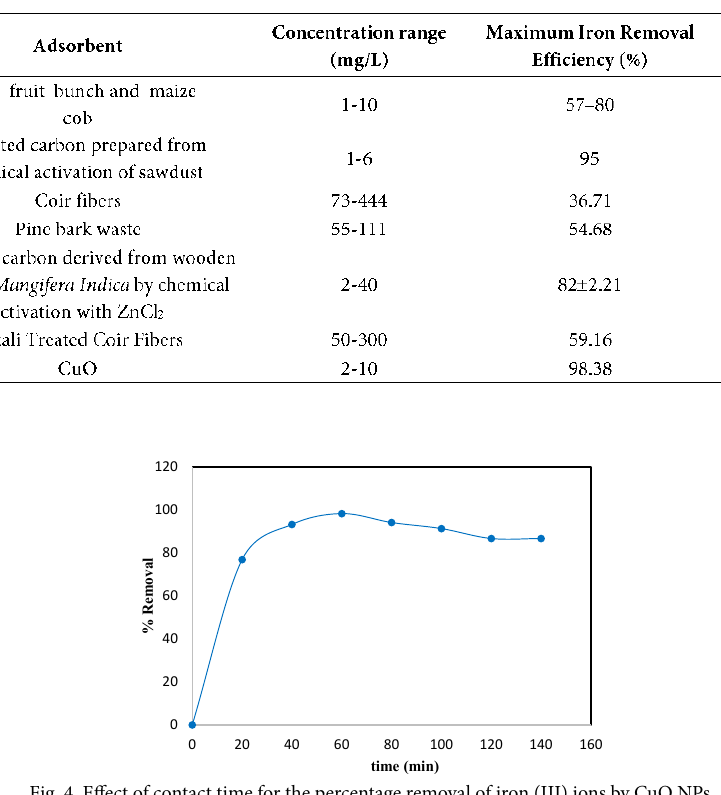
Table 2. Comparison of Iron removal capacity of CuO NPs with other adsorbents.